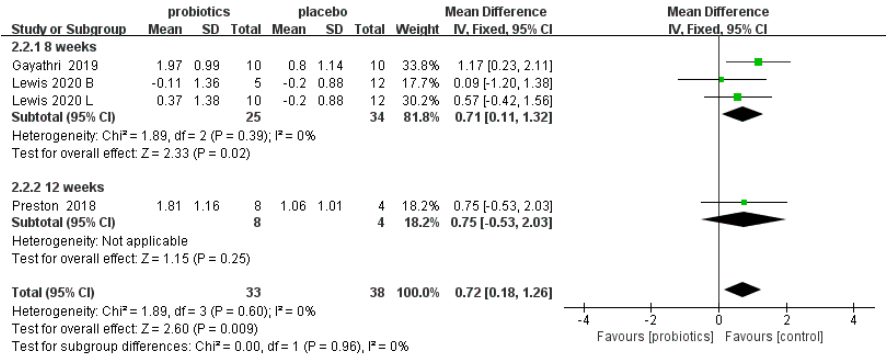
Figure 3. Effect of probiotics on stool consistency scores in IBS-C patients. The green block represents the effect sizes of individual studies, black diamond block represents the combined effect size.